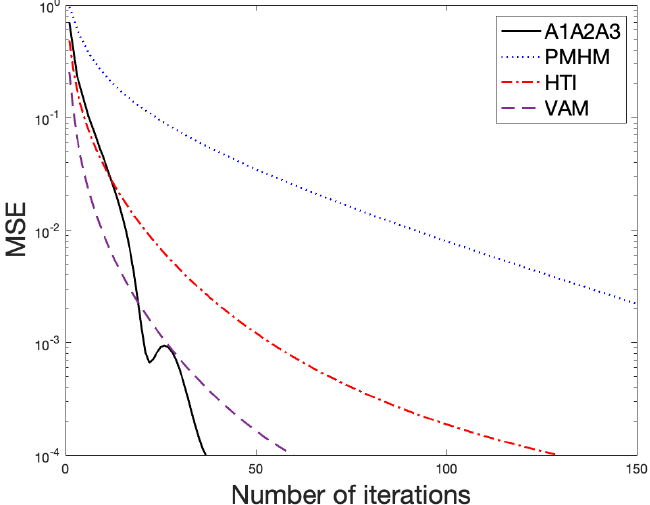
Figure 17. The graphs of the MSE for Algorithm 1 with A1A2A3 and the PMHM algorithm,